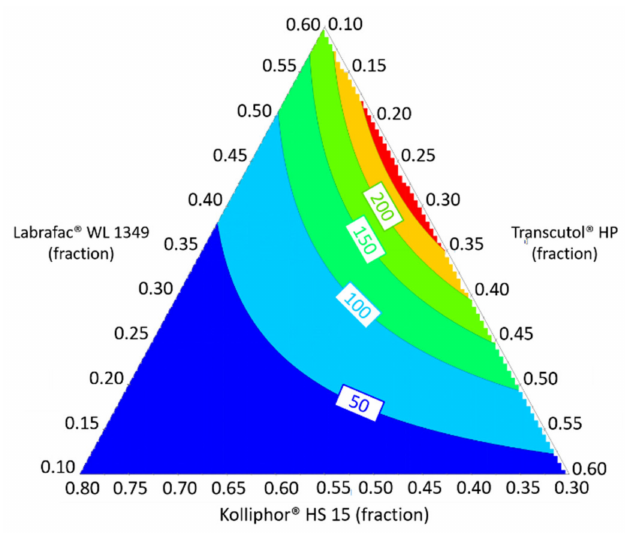
Figure 3. Response contour plot allowing the prediction of Y 1 : the average diameter from the regression